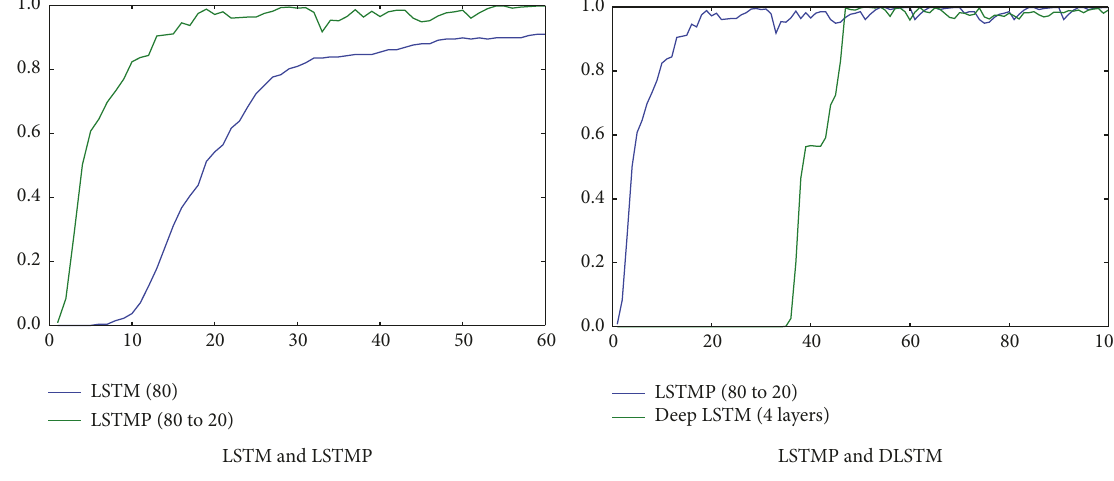
Figure 4: Comparisons of LSTM, LSTMP, and